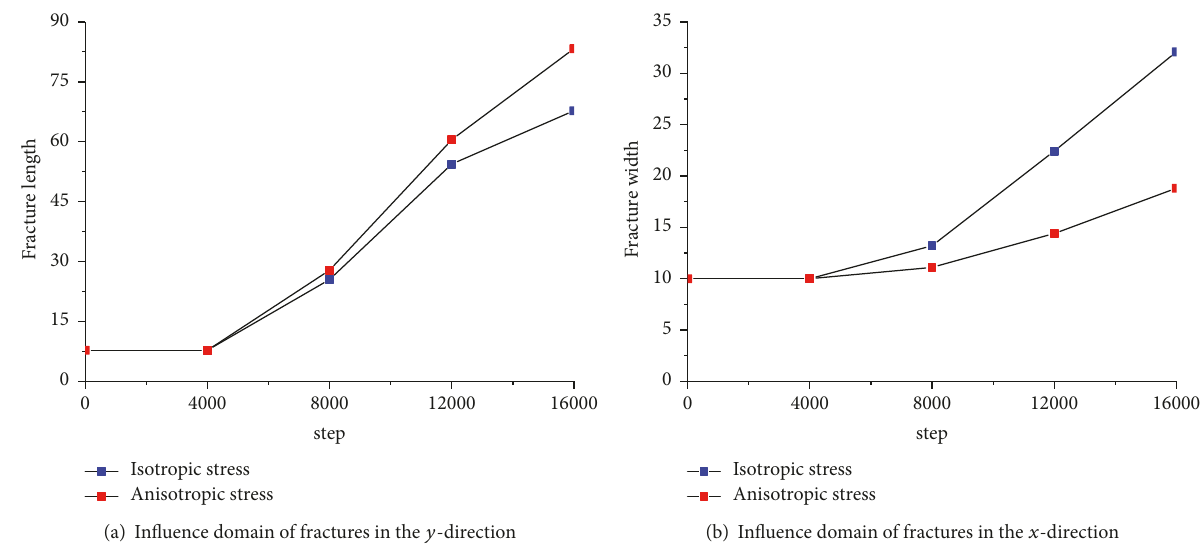
Figure 23: Influence domain of fractures under isotropic and anisotropic in situ stress conditions.